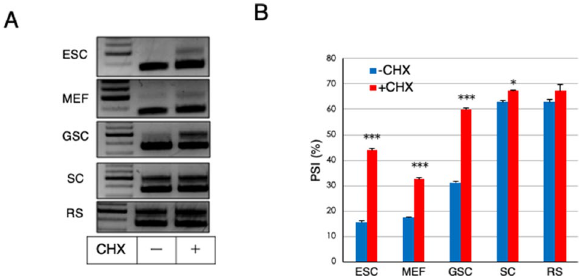
Figure 4. Inefficiency of NMD substantially contributes to accumulation of Mga SV transcripts in meiotic spermatocytes and spermatids. ( A ) High expression of Mga SV in spermatocytes and round spermatids was not further elevated by suppressing NMD activity. Non-germ (ESC and MEF) and germ (GSC, SC, and RS) cells were treated with or without CHX for 3 h. Semi-quantitative PCR was performed with cDNAs corresponding to their total RNAs. Full-length gels are presented in Supplementary Fig. S7. ( B ) Quantification of canonical and splice variant Mga mRNAs in non-germ and germ cells treated with or without CHX. cDNAs used in A were subjected to qPCR to accurately compare their amounts. Data are shown as PSI. Data represent the mean ± standard deviation of three independent experiments. The Student’s t-test was conducted to examine statistical significance. * P < 0.05; *** P <